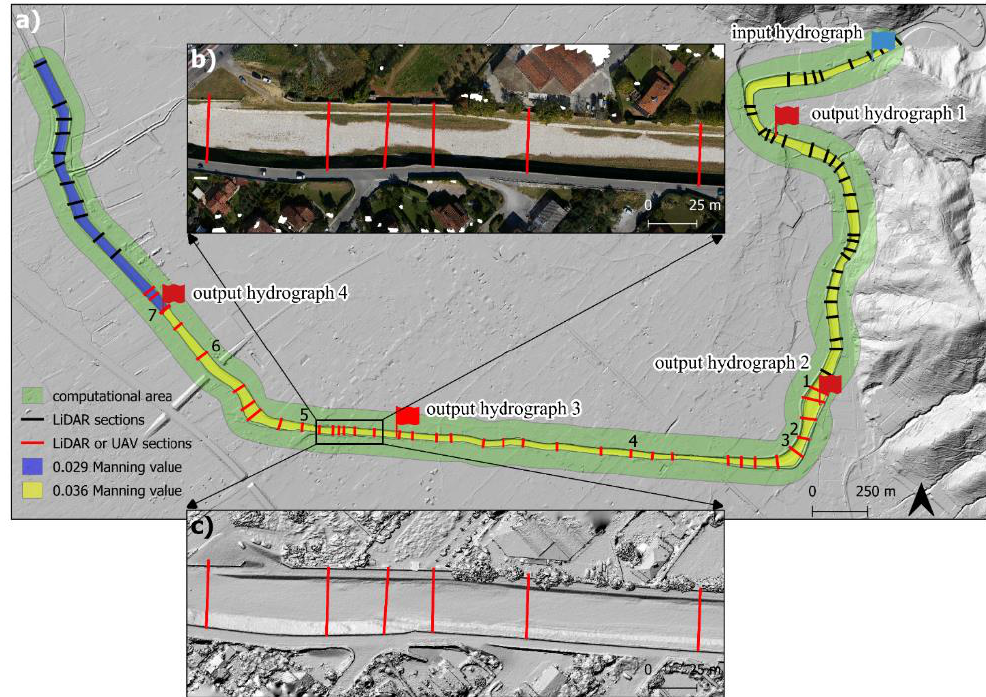
Figure 2. FLO-2D model set up. ( a ) Computational domain with FLO-2D model input sections (in green): sections extrapolated from LiDAR (in black) and sections extrapolated from LiDAR or UAV models as described in the text (in red). The blue flag shows the location of input hydrographs, while red flags show locations of output hydrographs. The yellow and blue polygons represent the Manning value of 0.036 and 0.029 used in the models. Numbers indicate the location of the cross-section profiles in Figure 7. The hill-shaded background is from the LiDAR DTM. ( b ) Ortomosaic zoom-in of a river segment, and location of the FLO-2D input sections (in red). ( c ) Hill-shaded zoom of the UAV DSM with the location of the FLO-2D input sections (in red).